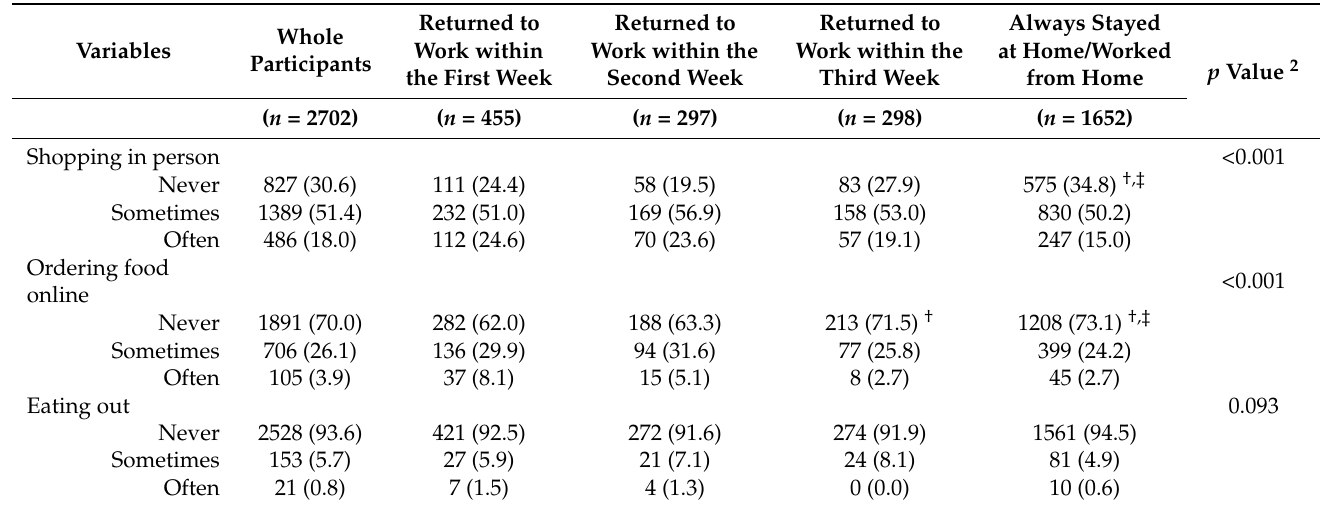
Table 2. Food access during the COVID-19 lockdown by status 1 .